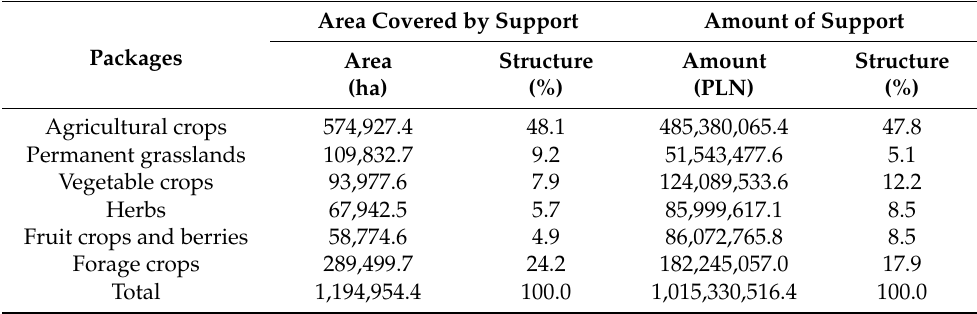
Table 6. Area under and support allocated to organic farming by package provided for in the 2014–2020